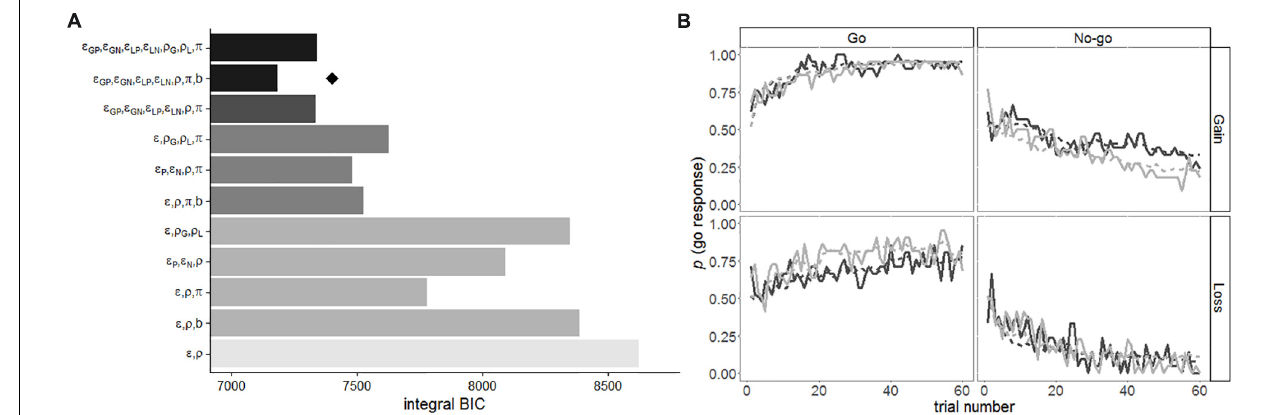
FIGURE 3 | (A) Each iBIC value for RL models. ε , learning rate; ρ , subjective impact of outcomes; b, action bias; π , Pavlovian factor. The subscripts represent the following: P, positive PE; N, negative PE; G, gain domain; L, loss domain. The brightness represents the number of parameters (as the number of parameters increases, the bar becomes darker). The diamond shape represents the winning model. (B) Average probabilities of choosing a go response in each trial for four conditions and the model predictions. The solid lines indicate the proportions of the go responses in each trial across participants, and the dashed lines show the predictions of the winning model. The black and gray lines represent the high- and low-psychopathy groups,